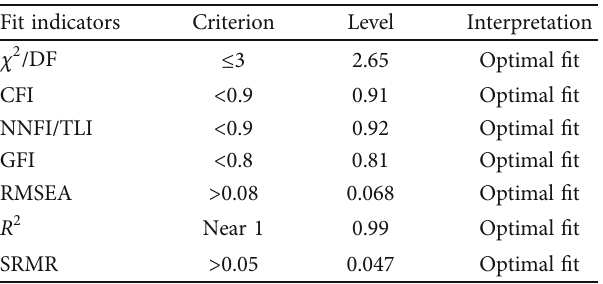
DF = 449 , p value = 0.056, chi- square = 1191 : 38 . TLI: Tucker-Lewis index; NFI: normed fi t index; GFI: goodness of fi t index; RMSEA: root mean square error of approximation; SRMR: standardized root mean square residual; CFI: comparative fi t index; R 2 : root mean square; χ 2 /DF: chi-squared distribution/degrees of